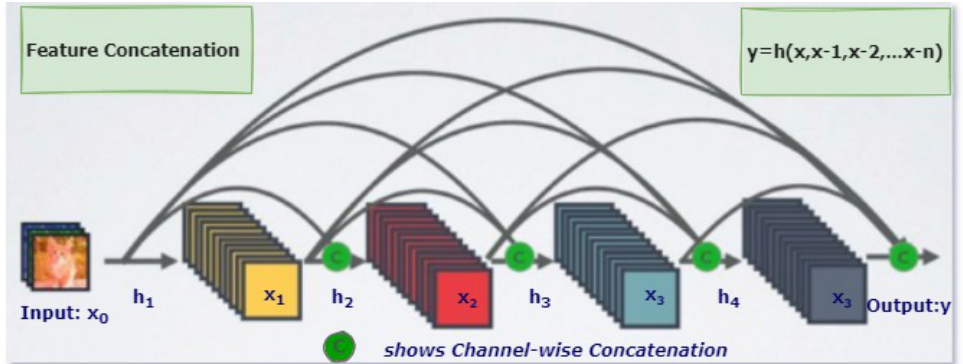
Figure 2. One Dense Block in DenseNet